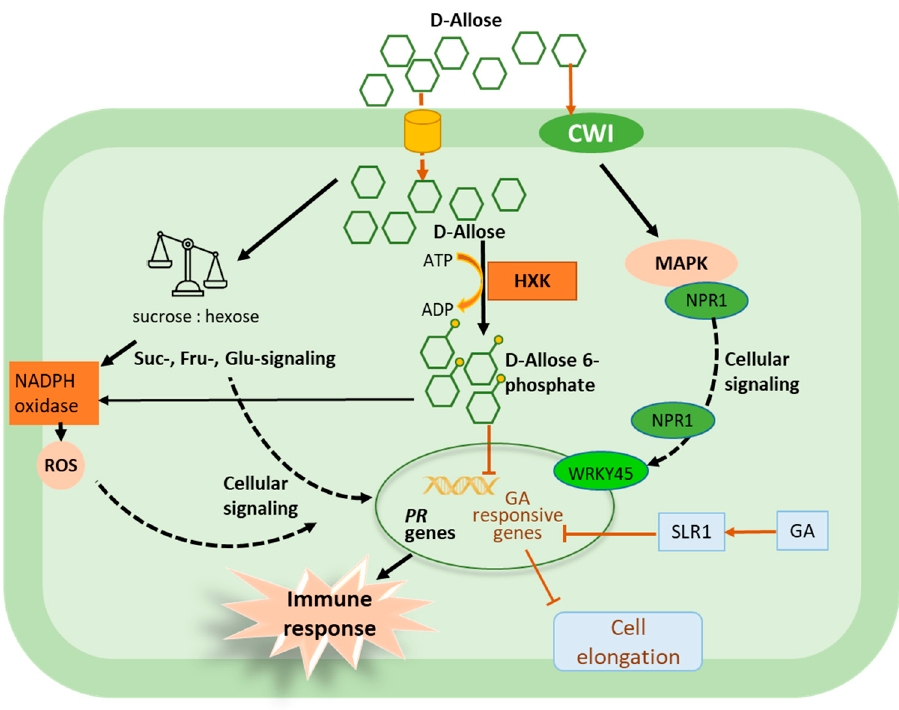
Figure 3. Schematic presentation of D-allose-triggered plant immunity and growth inhibition. After treatment D-allose can enter the plant cells through unknown mechanism, then phosphorylated by hexokinase (HXK) to produce D-allose 6-phosphate, which acts on the signal transduction downstream of DELLA protein (SLR1 in rice) as a suppressor of growth and gibberellin-dependent reactions. D-Allose can also activate NADPH oxidase leading to ROS production and resistance against Xanthomonas oryzae pv. oryzae [124]. Exogenous application of D-allose could also transiently upregulate extracellular cell wall invertase (CWI) activity, as reported for some nonmetabolizable sugars [152], resulting in activation of MAPK signaling pathway, transcription factors and cofactors such as WRKY 45 or Nonexpresser of PR (NPR1) genes—a key regulator of salicylic acid-mediated systemic acquired resistance pathway, and ultimately production of PR proteins. Penetration of D-allose inside the plant cell would also alter the sucrose:hexose ratio, thereby affecting the sugar signaling and triggering plant immune response.